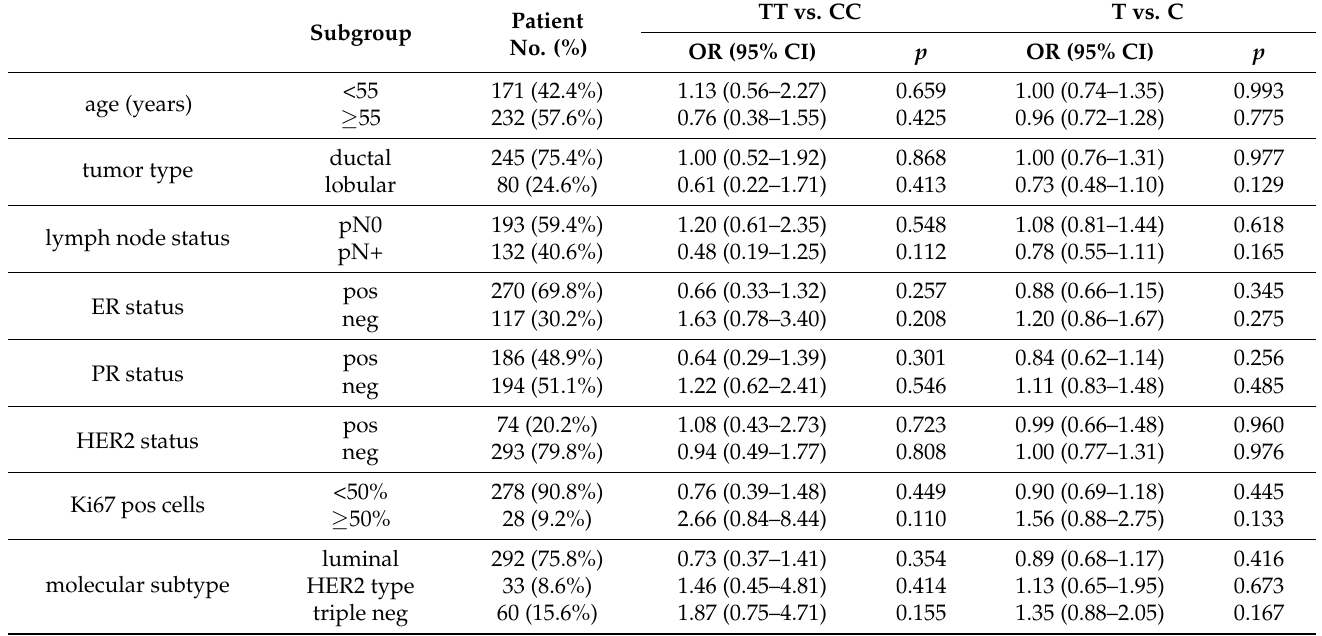
Table 2. Association of TERT SNV rs10069690 with breast cancer risk in patient subpopulations.